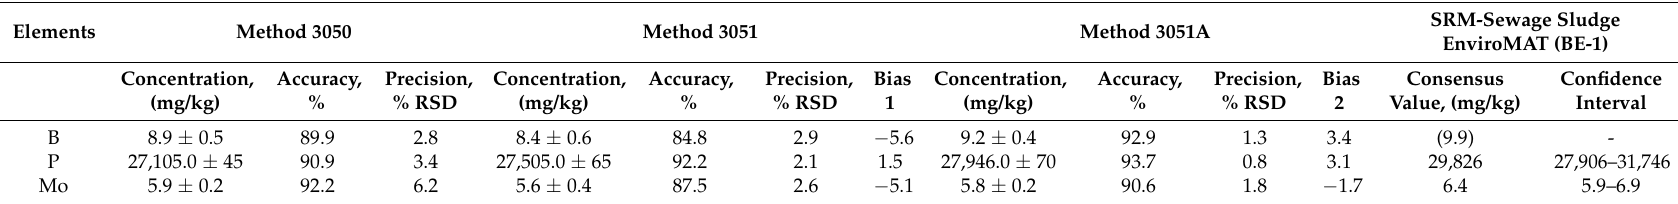
Table 5. Results (in mg/kg) of the analysis of Standard Reference Material (SRM)-sewage sludge EnviroMAT (BE-1) using different United States Environmental Protection Agency (USEPA) digestion methods.